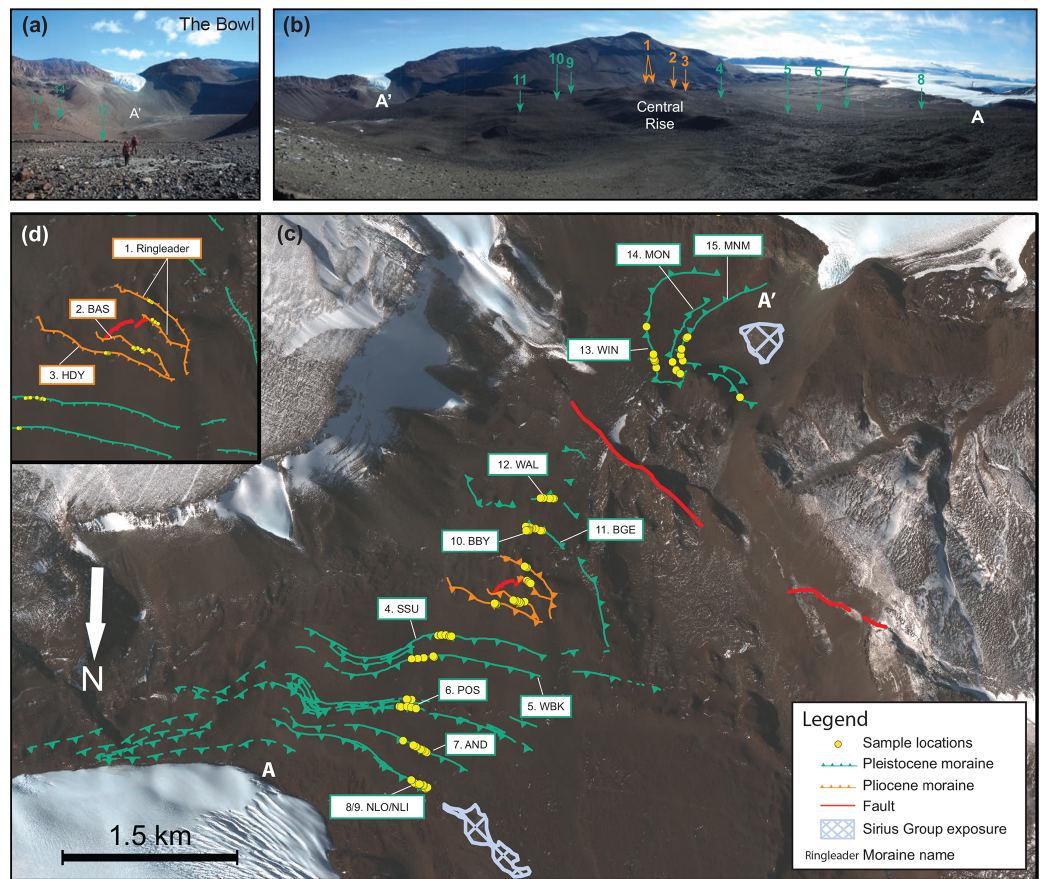
Figure 4. Map of Lower Roberts. (a) Photograph of the Bowl, showing cold-based drift and moraines overlying Sirius Group deposits, which appear light gray, and (b) photo of the Lower Roberts area. In (a) and (b) , arrows point to sampled moraines, with numbers corresponding to moraine names in (c) and (d) , and letters A and A (cid:48) corresponding to positions in (c) . (c) Glacial geomorphic map showing moraines and sample locations at Lower Roberts, as well as the location of observed Sirius Group outcrops. The NLO–NLI and POS are moraine complexes that comprise two or more crests, and the BBY moraine is a short moraine segment just north of the BGE moraine. (d) Closer view of the Pliocene-aged moraines encircling the Central Rise, shown in orange in (c) . The base map is derived from WorldView-2 satellite imagery (© 2017, DigitalGlobe,